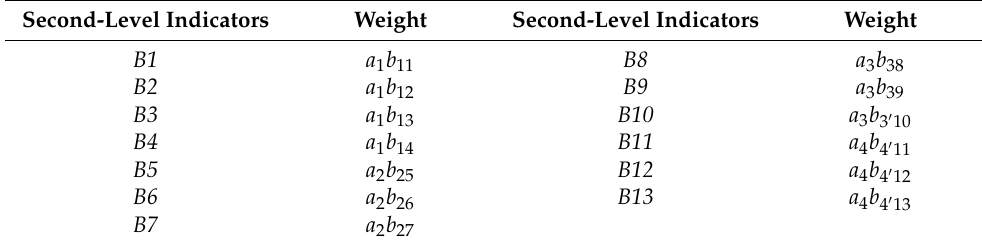
Table 4. Weight Values of the Second-Level Indexes.